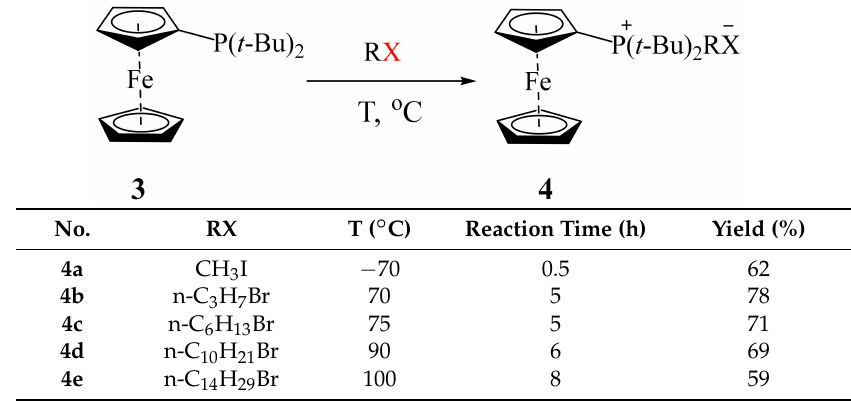
Table 1. Preparation of ferrocene-containing phosphonium salts. Details of the reaction conditions are in the supplementary material.